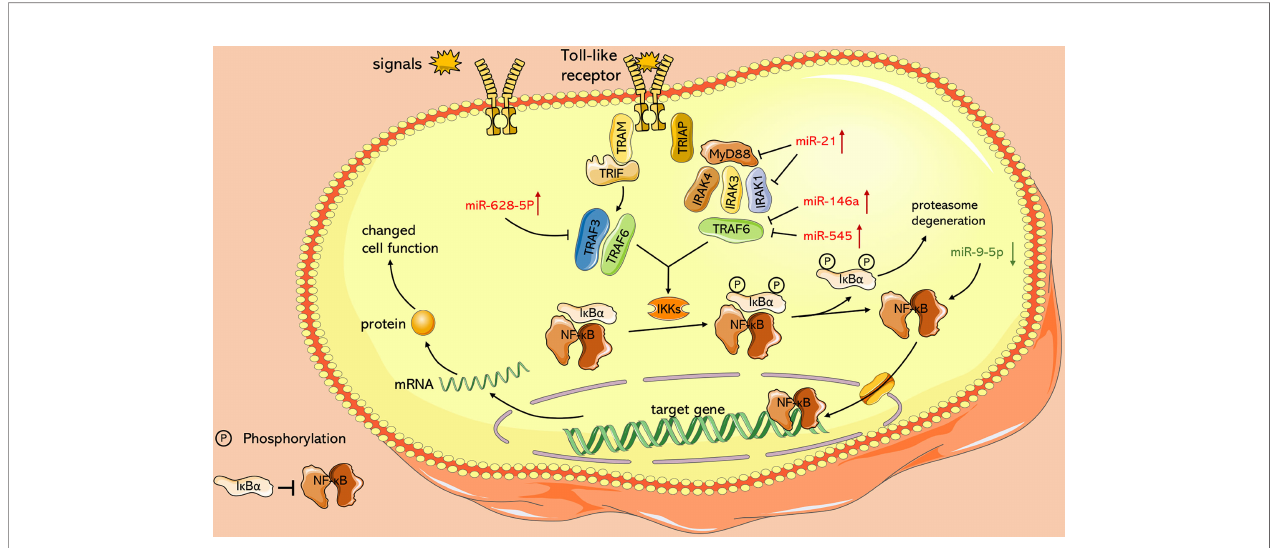
FIGURE 3 | Role of ncRNAs in activation of NF- k B pathway with TLR signaling as an example. Toll-like receptors activate and recruit TIR-containing adaptor molecules, MyD88 and TRIF, which prime downstream effectors respectively, under the stimulation of signals such as LPS. Both of upstream signal paths fi nally transfer signals to IKKs, the protein kinase of I k B, and relieve inhibition of NF- k B. miR-628-5p, miR-21, miR-146a, miR-545 and miR-9-5p play an essential role in this